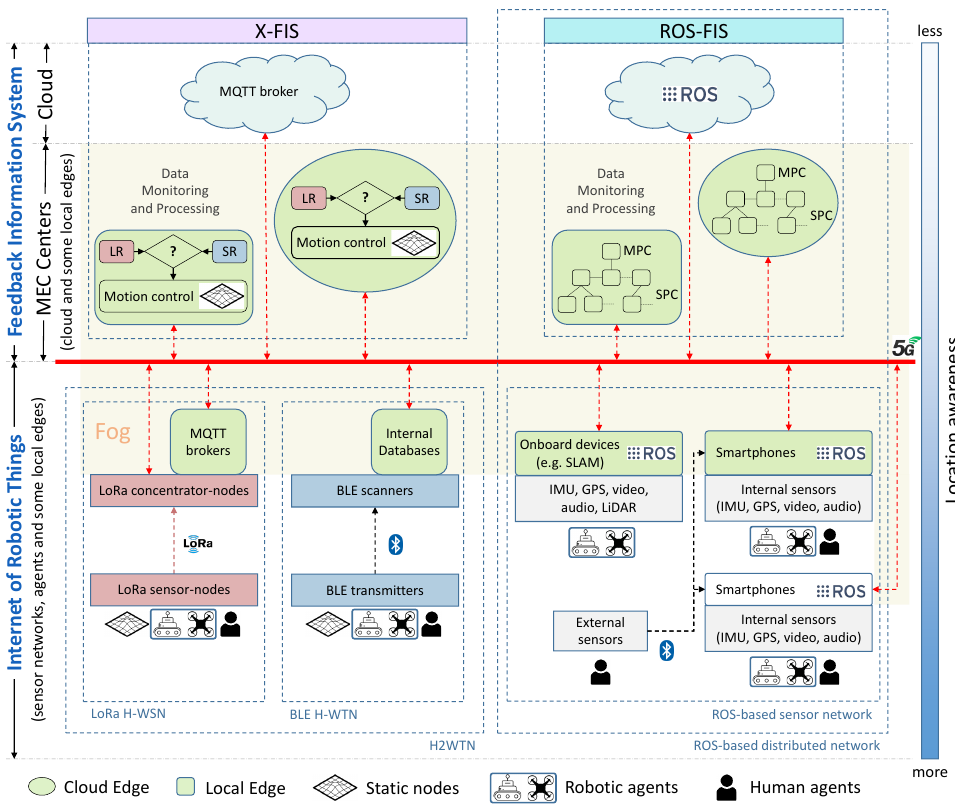
Figure 1. Internet of cooperative agents architecture